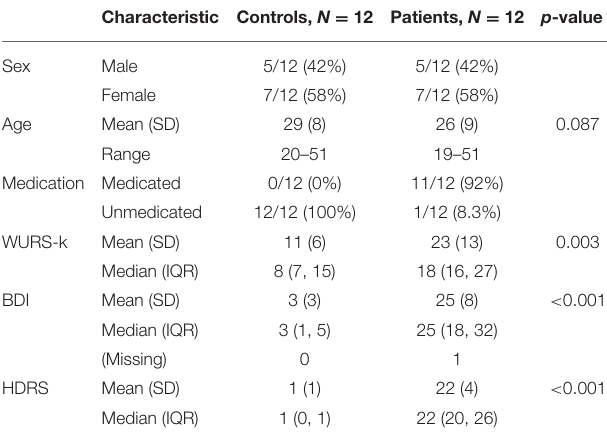
TABLE 2 | Demographic and psychometric